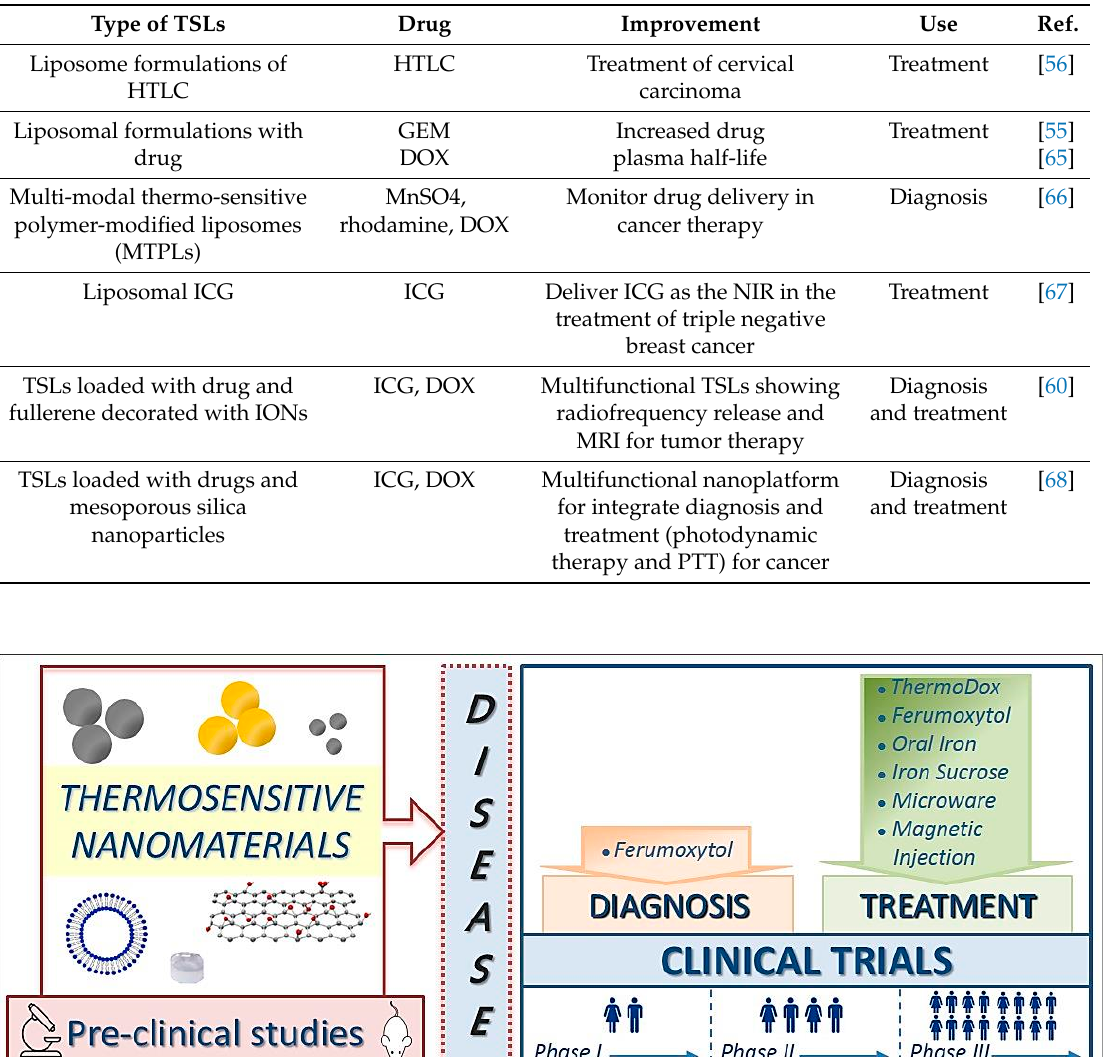
Table 1. New TSLs systems developed for cancer treatment and diagnosis.